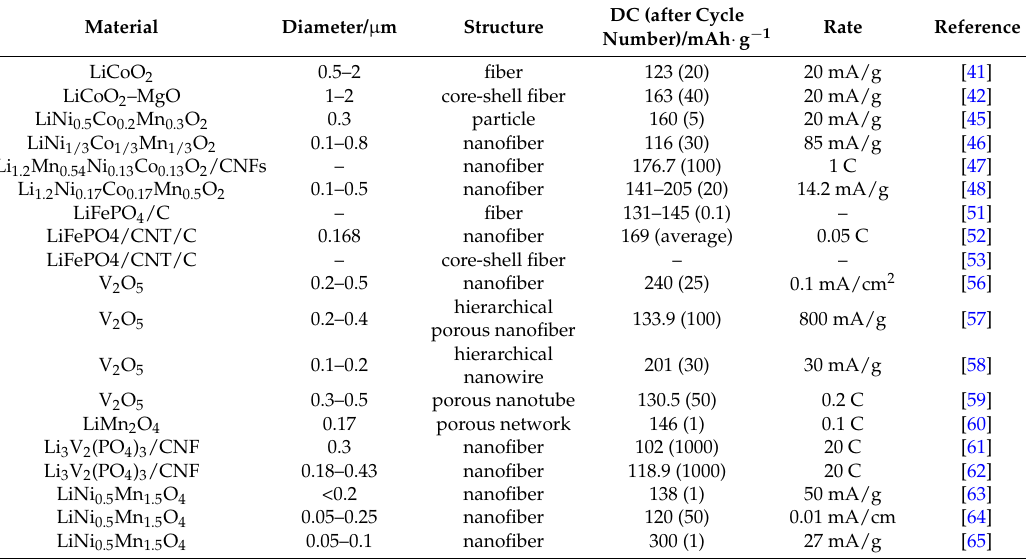
Table 1. Electrospun cathode materials for Li-ion batteries (LIBs) and the corresponding electrochemical performance. DC: Discharge